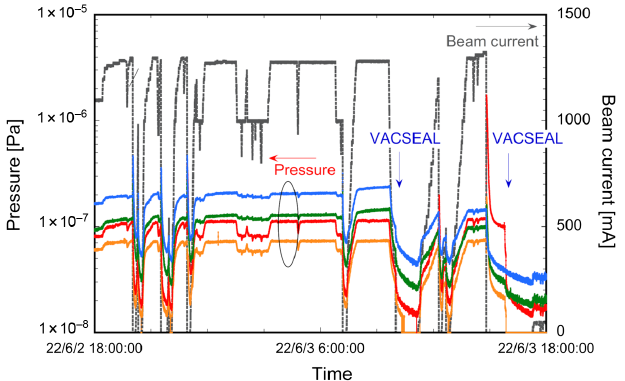
FIG. 32. Trends of beam current and pressures around a beam pipe at the downstream of Oho wiggler section from 2022.